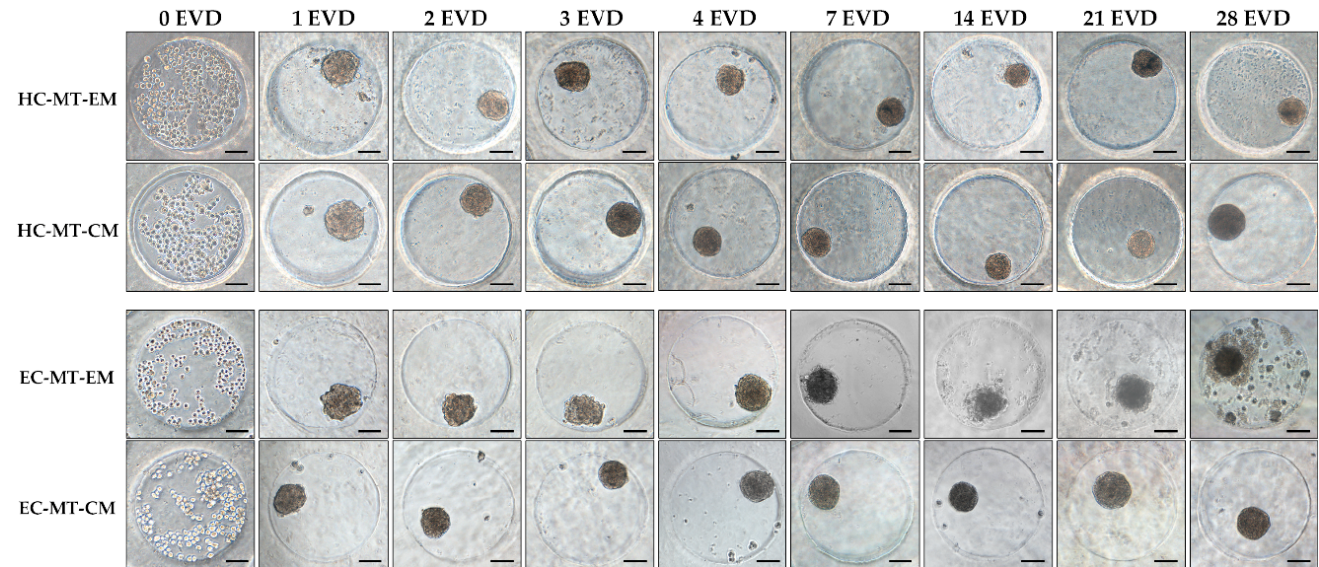
Figure 1. Time course phase-contrast microscopy of human chondrogenic microtissues (MTs) formation process. Note how the cells appear spread within the microchip at 0 days of ex vivo development (EVD), and after 24 h, they associate, forming MTs. Images show hyaline cartilage-derived microtissues (HC-MTs) and elastic cartilage-derived microtissues (EC-MTs) cultured in expansion media (EM) or chondrogenic media (CM). Scale bar = 100 µm.